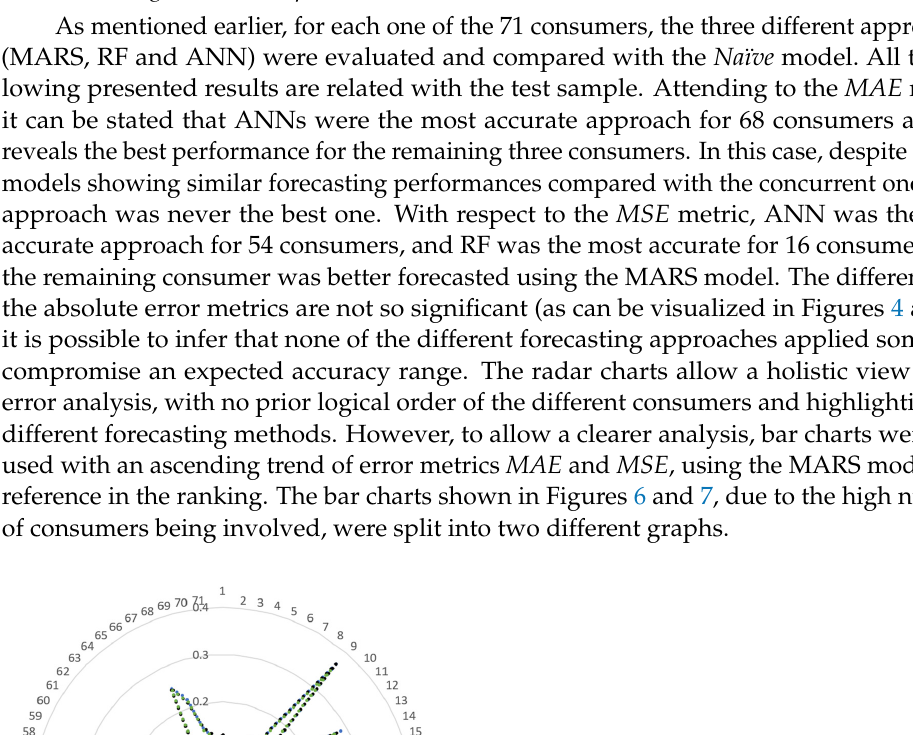
Figure 5. Radar chart involving MSE (in kWh 2 ) for different Consumer IDs.